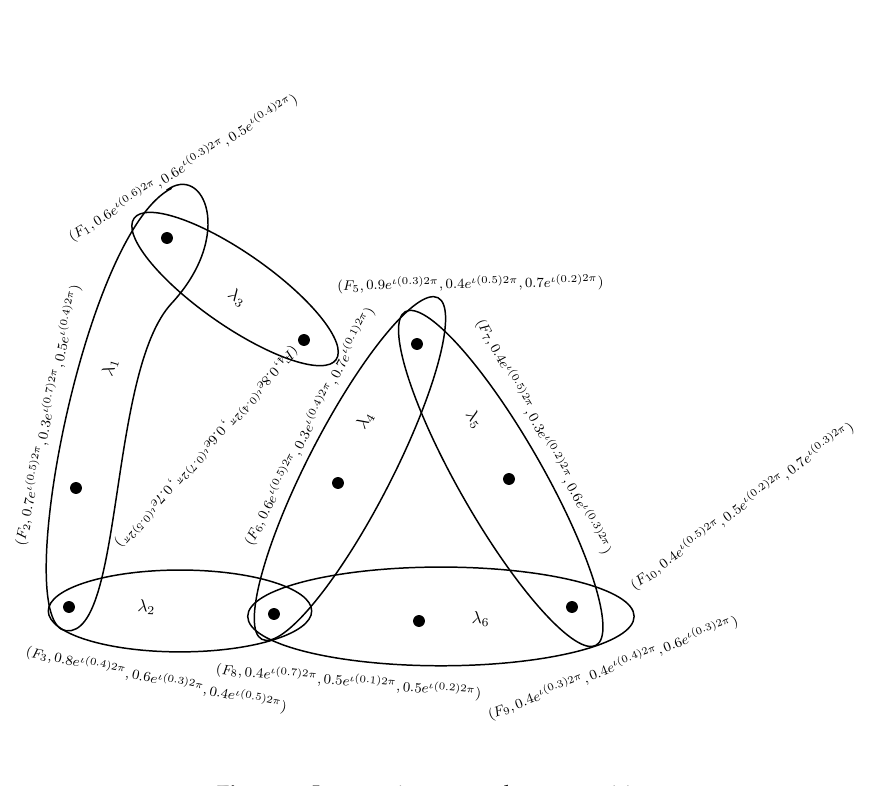
Figure 8. Intersecting research communities.